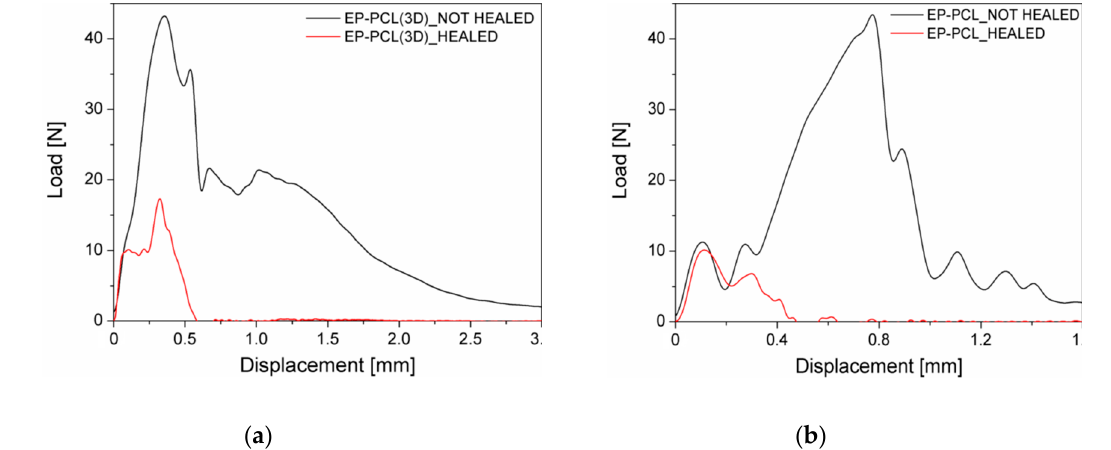
Figure 7. Representative load–displacement curves of ( a ) EP-PCL(3D) and ( b ) EP-PCL samples (healed and not healed) obtained in fracture toughness tests under impact conditions. Table 3. Healing efficiency values of EP-PCL(3D) and EP-PCL samples under quasi-static and impact conditions